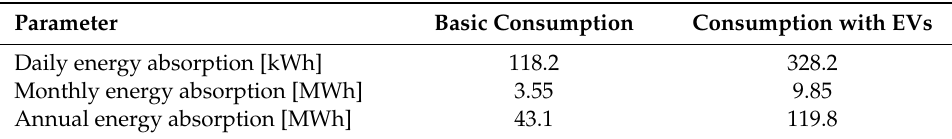
Table 2. Overall energy absorption of the car park.